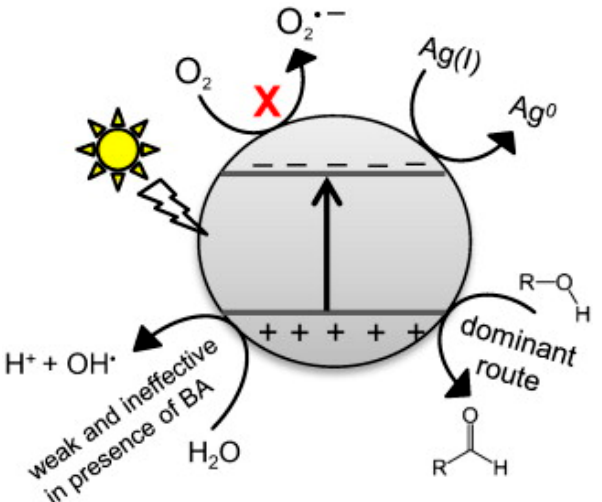
Figure 25. Schematic showing involvement of O 2 − • , OH • and holes in the selective photocatalytic oxidation of alcohols. R = aryl group. Reprinted with permission from reference [175]. Copyright 2015 Elsevier.